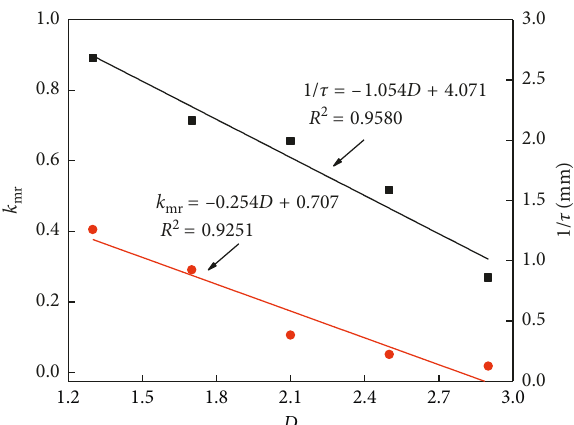
Figure 13: The variation of the minimum permeability ratio k and average aperture 1/ τ with the variation of fractal